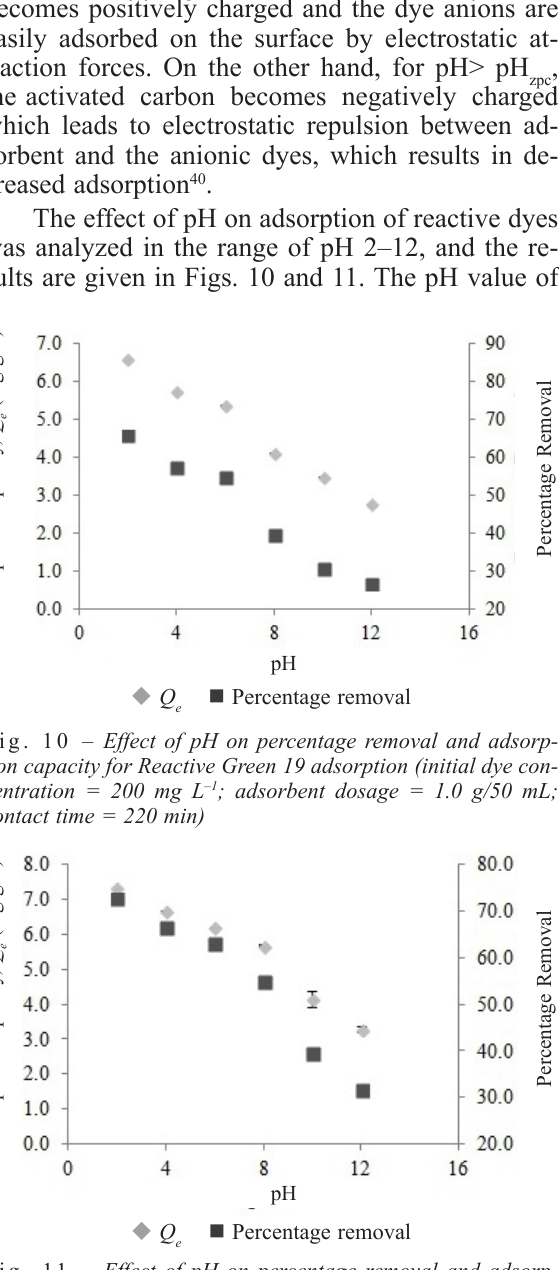
Fig. 9 – Effect of adsorbent dose on percentage removal and adsorption capacity for Reactive Red 141 adsorption (initial dye concentration = 200 mg L –1 ; pH = 6; contact time = 180